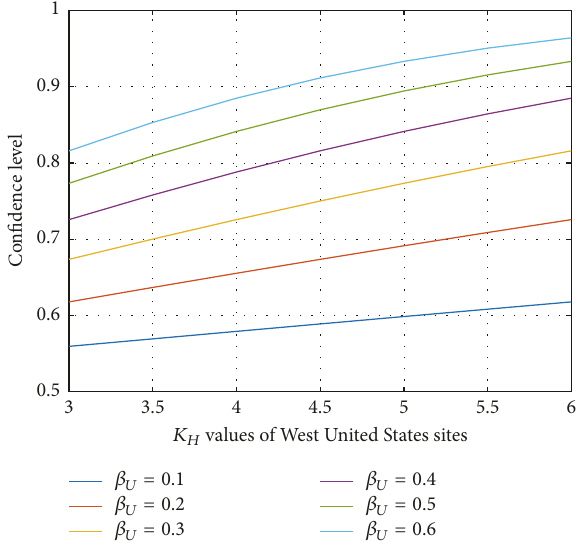
Figure 1: Confidence levels of mean seismic probability risk model used in West United States sites.